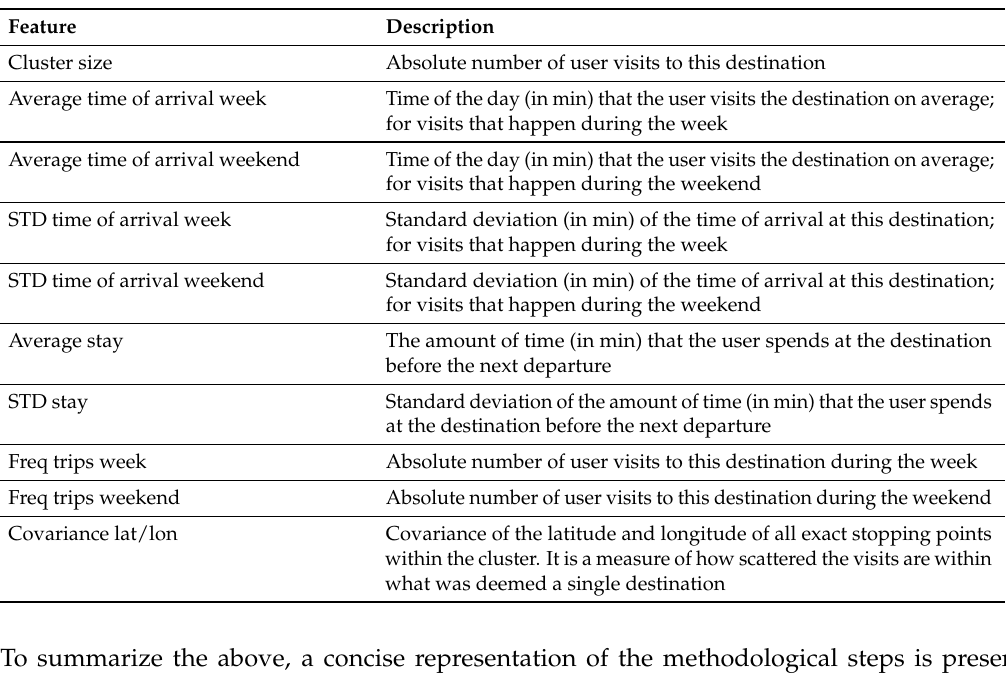
Table 1. List of generated features that constitute properties of an individual destination/cluster of the user’s totality of trips.